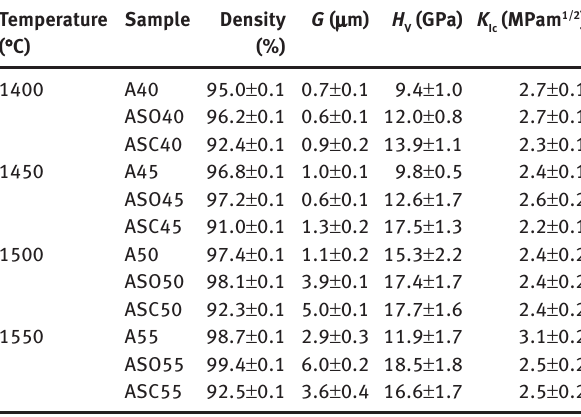
Table 1: Physical and mechanical properties of all samples. Temperature